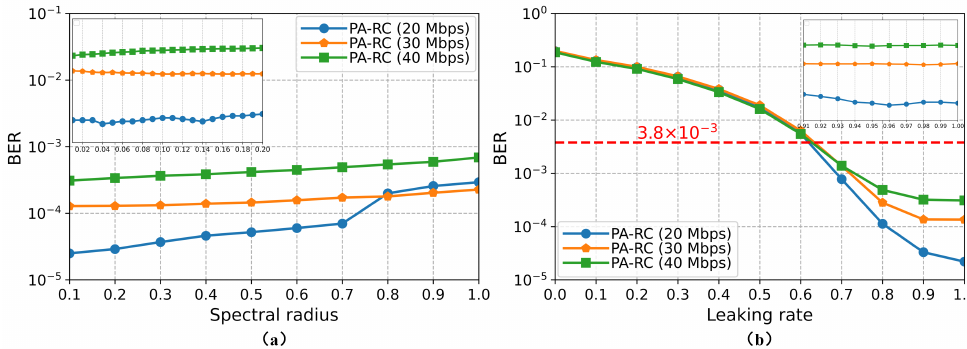
Figure 4. BER vs. RC parameters. ( a ) Spectral radius; ( b ) leaking rate.